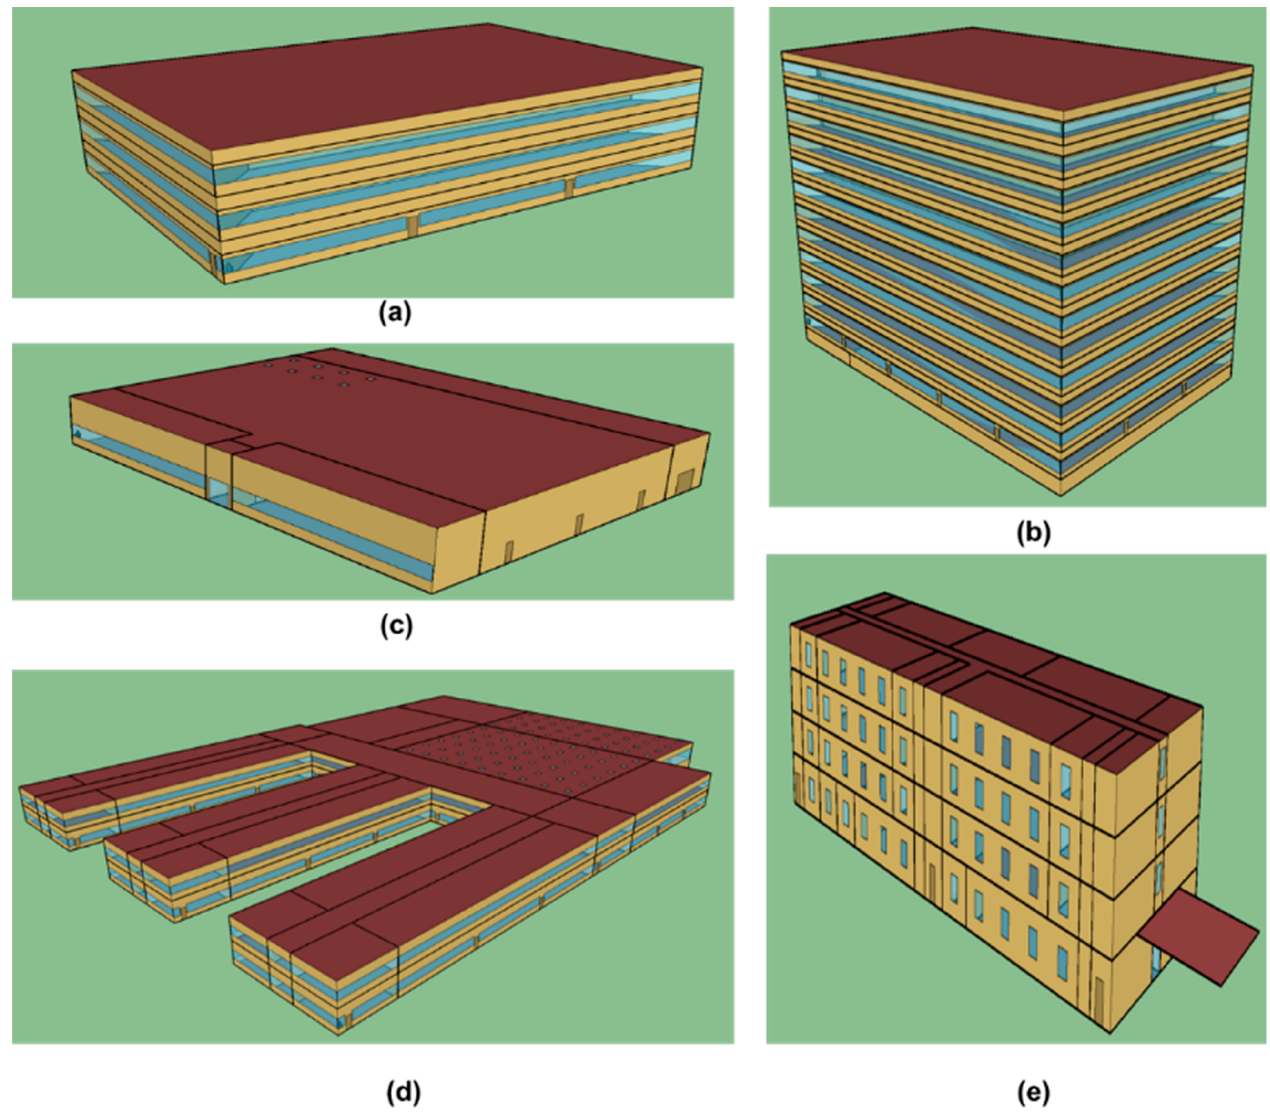
Figure 2. DOE prototype models in CONTAM: ( a ) Medium Office, ( b ) Large Office, ( c ) Stand-Alone Retail, ( d ) Secondary School, and ( e ) Small Hotel.